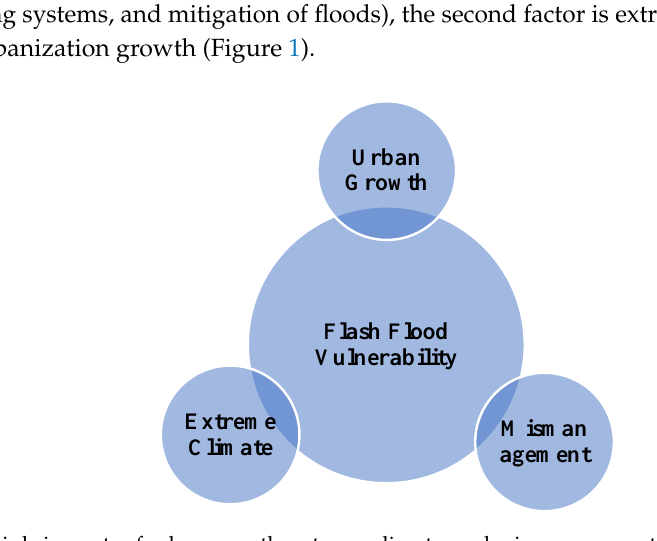
Figure 1. Triple impacts of urban growth, extreme climate, and mismanagement on flash flood disasters.